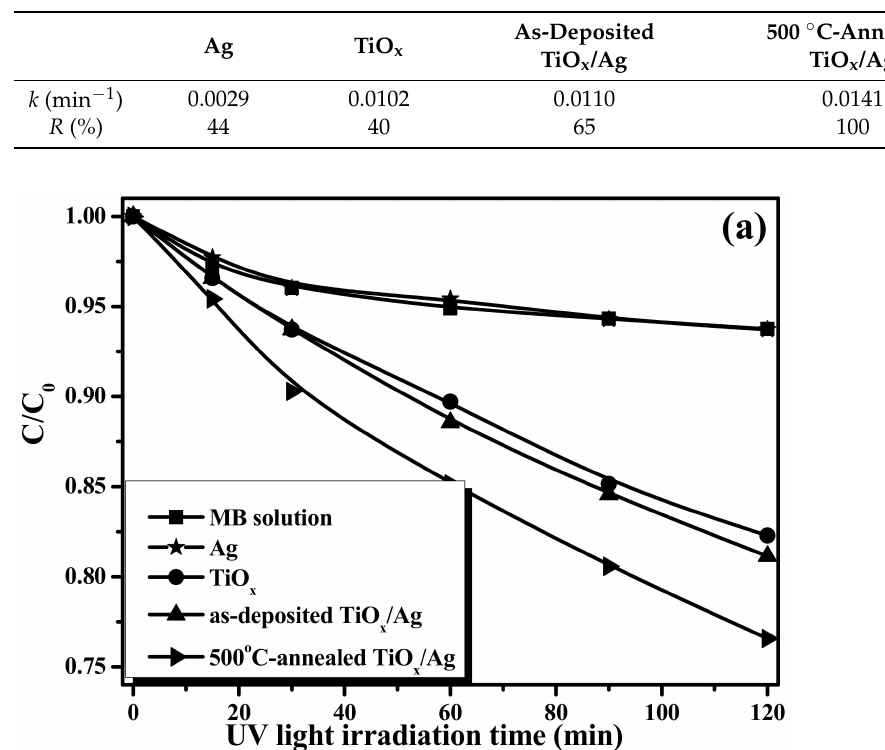
Table 1. Rate constant ( k ) and reduction percentage ( R ) of the Ag, TiO x , as-deposited TiO x /Ag, and 500 ◦ C-annealed TiO x /Ag samples.